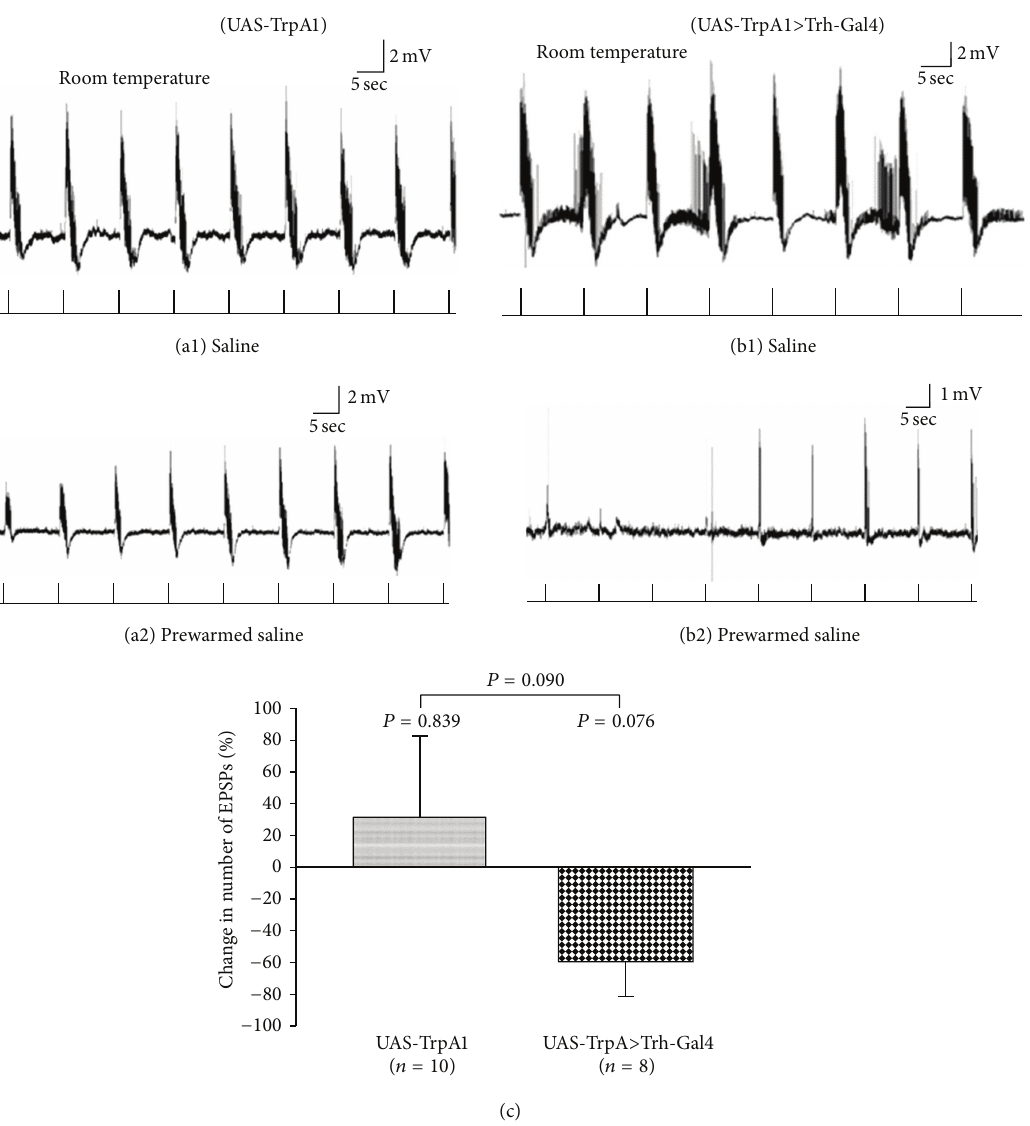
Figure 15: Induced activity in 5-HTergic neurons and sensory-motor physiology in third-instar larvae. (a1) The segmental nerves of dissected control (UAS-TrpA1) third-instar larvae were stimulated at 40 Hz, 10 pulses, in saline at room temperature. (a2) The saline was exchanged with prewarmed saline in a water bath (37 ∘ C) and then applied to the preparation at 32–34 ∘ C. (b1) 5-HTergic neurons expressing temperature sensitive cation channel, TrpA1 (Trh-Gal4 (III) > UAS-TrpA1). The evoked activity (EPSPs) of sensory-motor neural circuit was recorded at room temperature (22-23 ∘ C) saline. (b2) Saline was switched with prewarmed saline in a water bath (37 ∘ C) when the evoked activity was being recorded. Activation of 5-HTergic neurons significantly reduced evoked neural activity. The prewarmed saline was transferred to the dissection dish for both control and TrpA1 expressing third-instar larvae. (c) Activation of 5-HT neurons markedly reduced the number of EPSPs compared to control larvae. Paired 𝑡 -test was used to compare the frequency of EPSPs inside room temperature saline and prewarmed saline. Student’s 𝑡 -test was used to compare different treatments. Data represented as mean ±